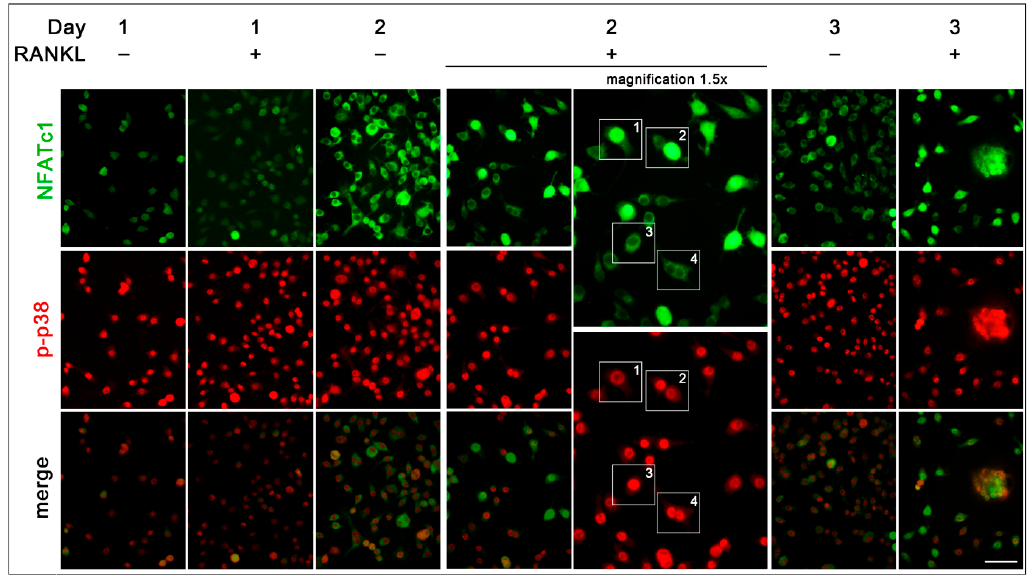
Figure 7. NFATc1 and p-p38 subcellular co-localization. Cells were cultured in the absence (RANKL − ) or in the presence of RANKL (RANKL + ) for 1, 2, and 3 days. Cells were stained with anti-NFATc1 (green) and p-p38 (red) antibodies. White frames 1 and 2 indicate 1.5 × magnifications of NFATc1 nuclear localization. White frames 3 and 4 indicate 1.5 × magnifications of NFATc1 cytoplasmic localization. The data shown represent two independent experiments with comparable outcomes. Magnification 40×. Scale bar of 50 µm.